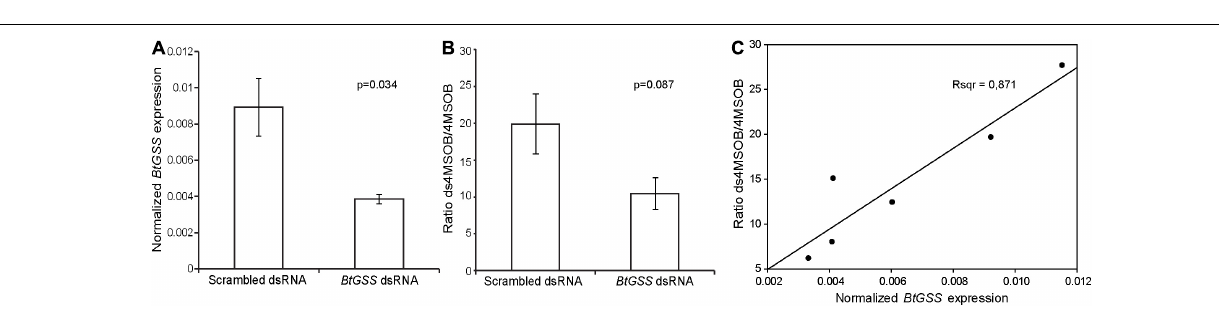
PYK10 (Bednarek et al., 2009; Clay et al., 2009; Nakano et al., 2017), which may be more specific to indolic